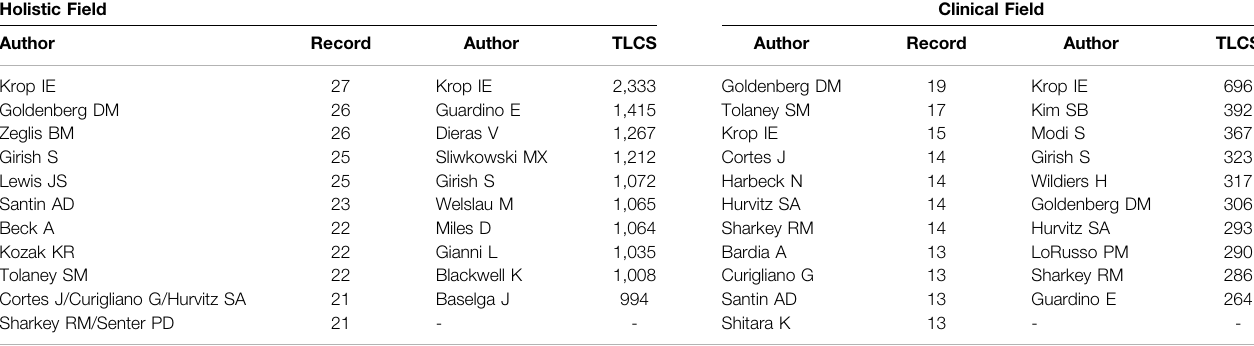
TABLE 2 | The top 10 authors and cited authors of ADC research in the solid cancer fi eld [n (%)]. Holistic Field Clinical